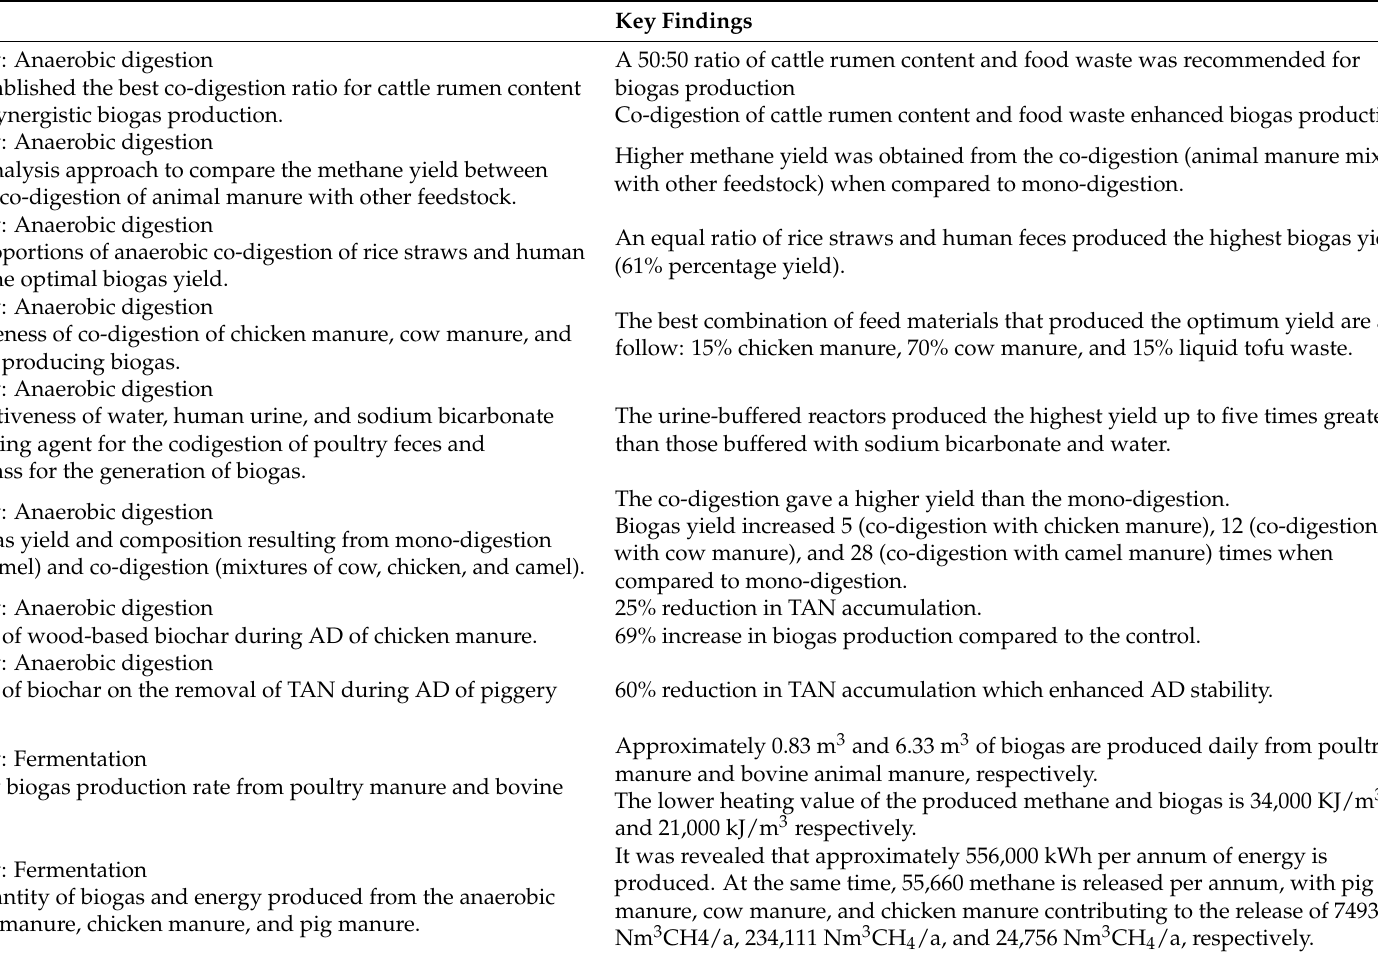
Table 7. Summary of past studies on anaerobic digestion and fermentation of human and livestock